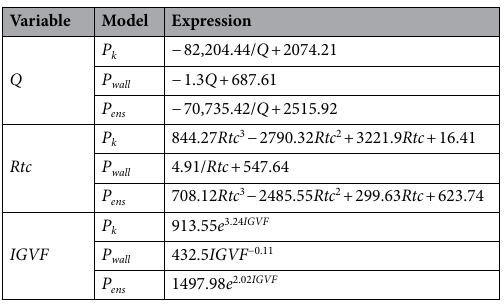
Table 4. Simple regression models.